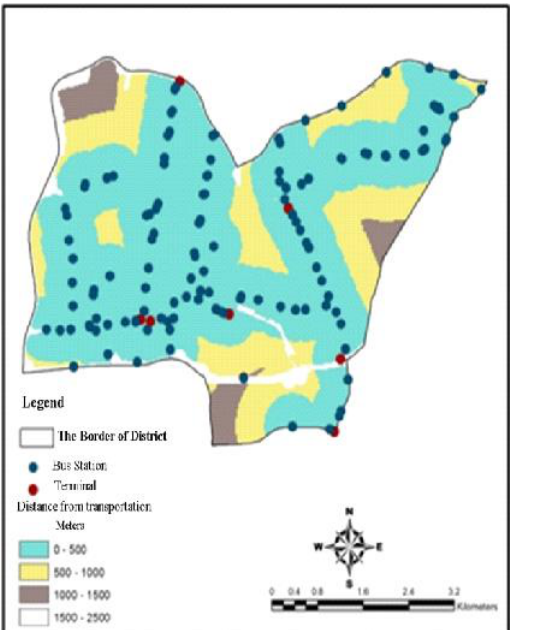
Fig. 9: The population